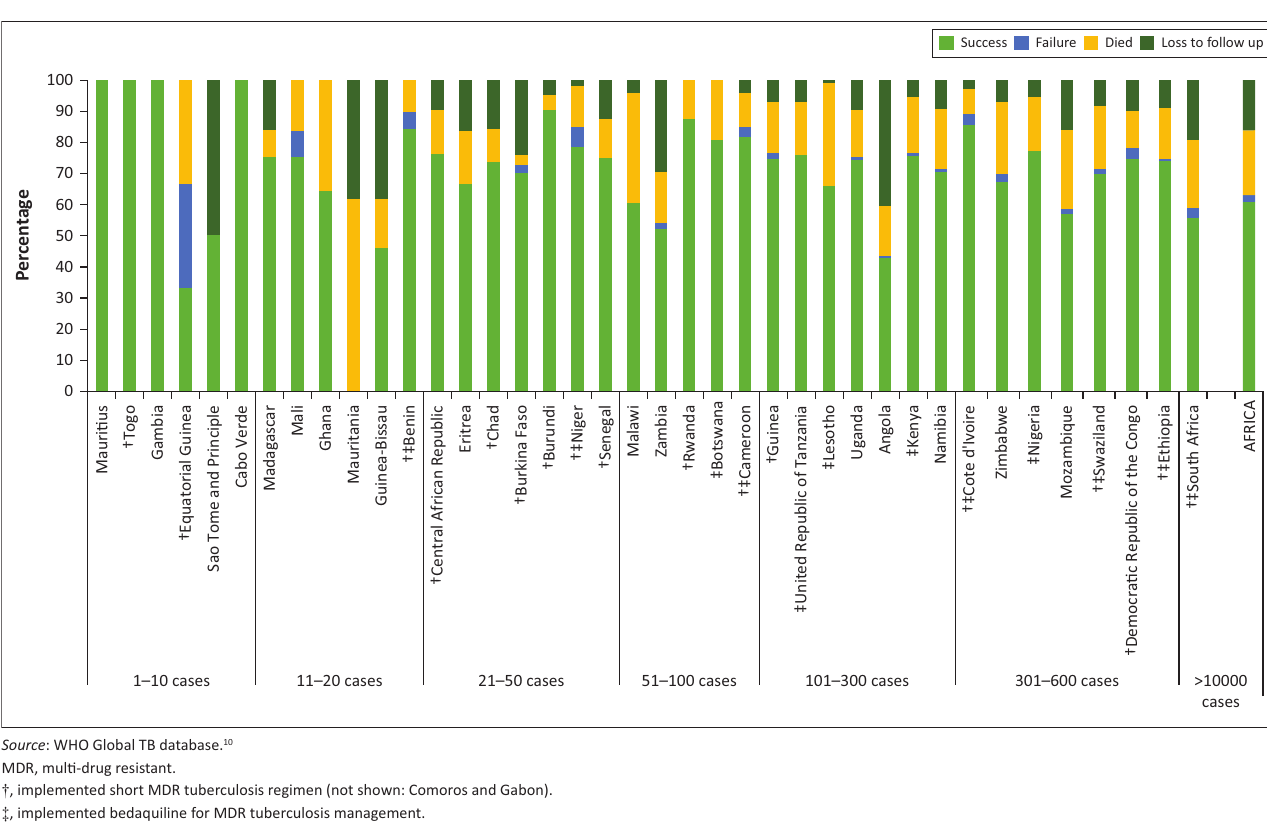
FIGURE 1: Multi-drug-resistant tuberculosis outcomes by country grouped by size of cohort: 2014. Countries with no data or no reported cases are not (Table 3). Availability of second-line drug susceptibility testing has, however, not translated into practice with only 43 % (12/28) of these countries testing more than half their notified rifampicin-resistant tuberculosis cases. However, these percentages are not truly reflective, as they are based on the number of detected rather than estimated cases.